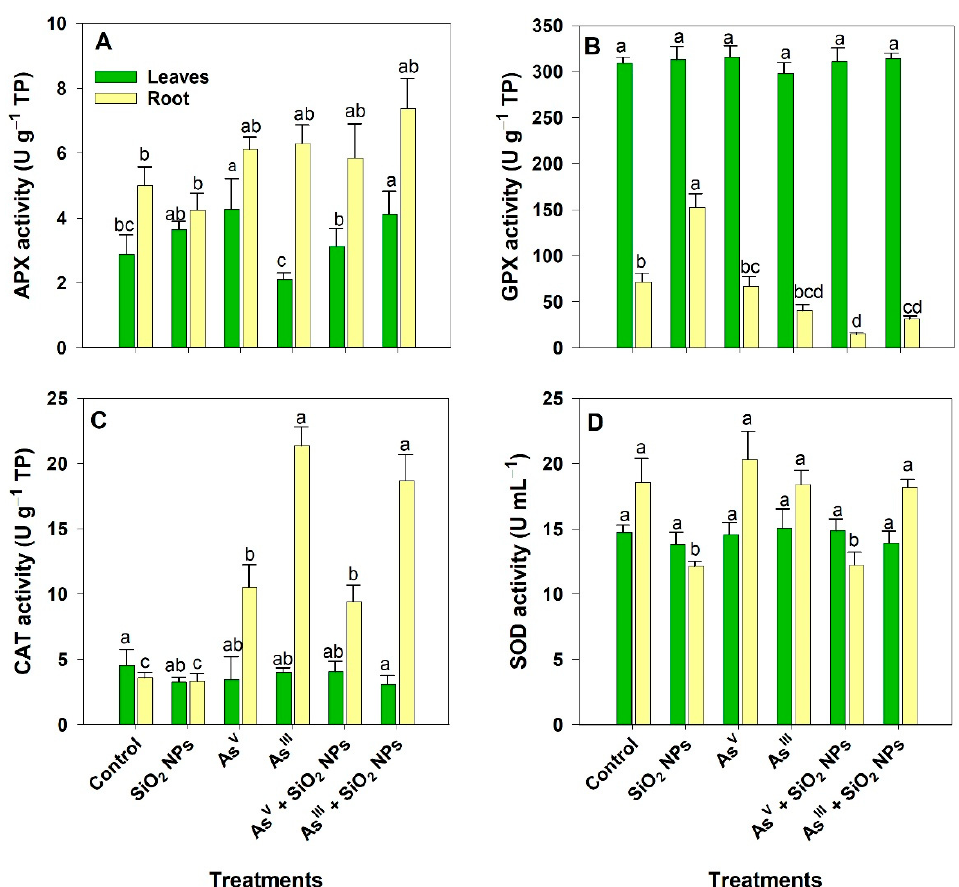
Figure 5. Antioxidant enzyme activity in the roots and leaves of tomato plants. ( A ) APX: ascorbate peroxidase, ( B ) GPX: glutathione peroxidase, ( C ) CAT: catalase, and ( D ) SOD: superoxide dismutase. Plants treated with 3.2 mg L − 1 of As V (Na 2 HAsO 4 ∙ 7H 2 O) and As III (NaAsO 2 ) via irrigation through the nutrient solution and 1000 mg L − 1 of SiO 2 NPs via substrate. Lower-case letters different per bar indicate statistical differences according to the Fisher’s least significant difference test ( p ≤ 0.05). n = 5 ± standard